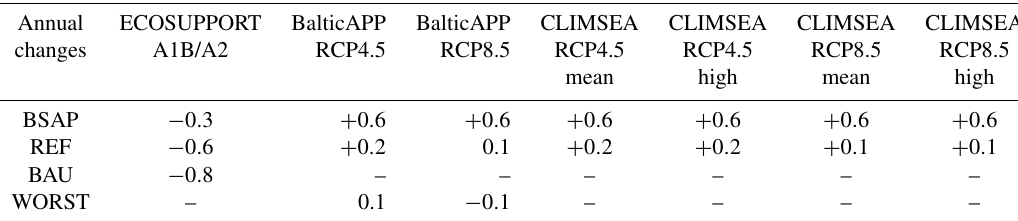
Table 11. As in Table 8 but showing the ensemble mean changes in the annual Secchi depth (in m) in the ECOSUPPORT, BalticAPP RCP4.5, BalticAPP RCP8.5, CLIMSEA RCP4.5 and CLIMSEA RCP8.5 scenario simulations averaged for the Baltic Sea including the Kattegat. The projected changes depend on the nutrient input scenario: BSAP, REF, BAU or WORST. (Data sources: Meier et al., 2011b, 2021; Saraiva et al., 2019a.)